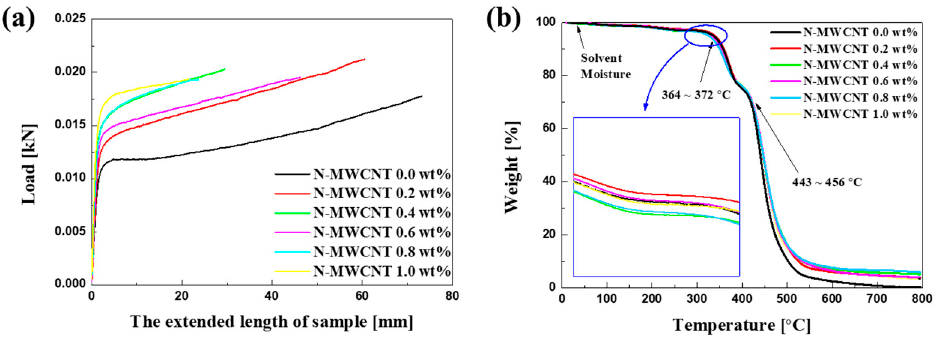
Figure 6. ( a ) Tensile moduli and ( b ) thermo-gravimetric analysis (TGA) curves of casted HPTS Nafion membrane without MWCNTs and N-MWCNT membranes with different MWCNT weight ratios (inset: enlargement of 364–372 °C TGA range).